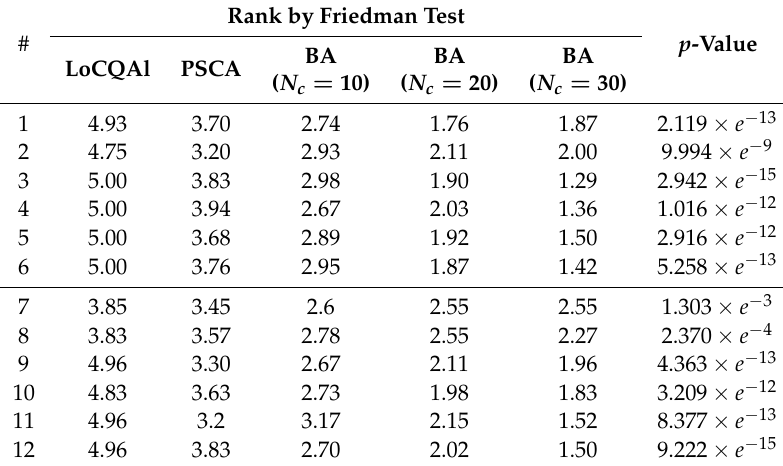
Table 7. Ranking by Friedman test for each scenario in the second experiment.